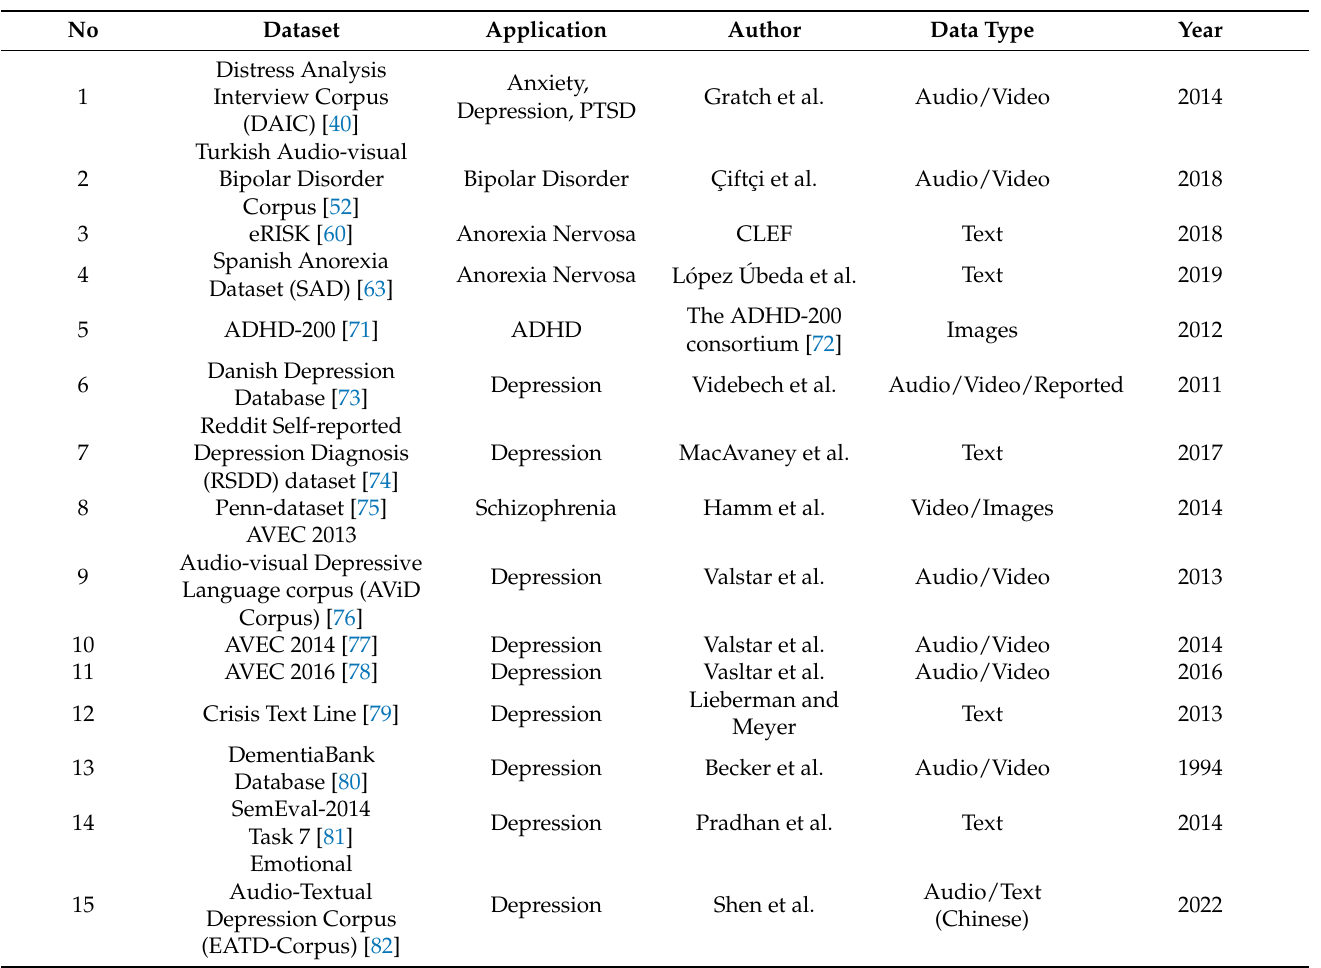
Table 2. Datasets for various mental health